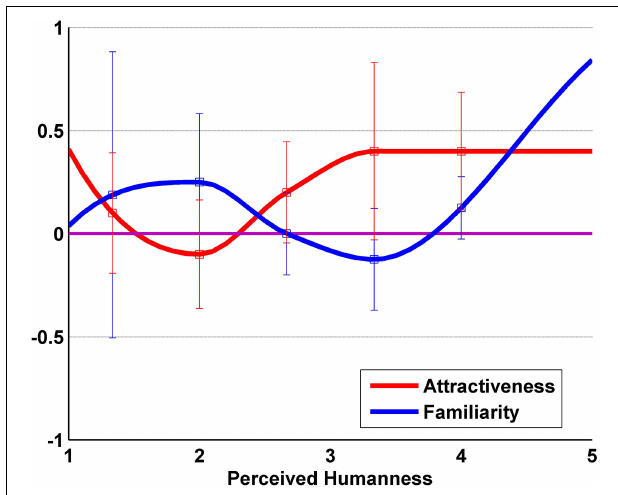
FIGURE 4 | Our Uncanny valley. Perceived Humanness and Familiarity (reverse scaled Eeriness) are plotted in order to describe the Uncanny valley. Attractiveness is also plotted as